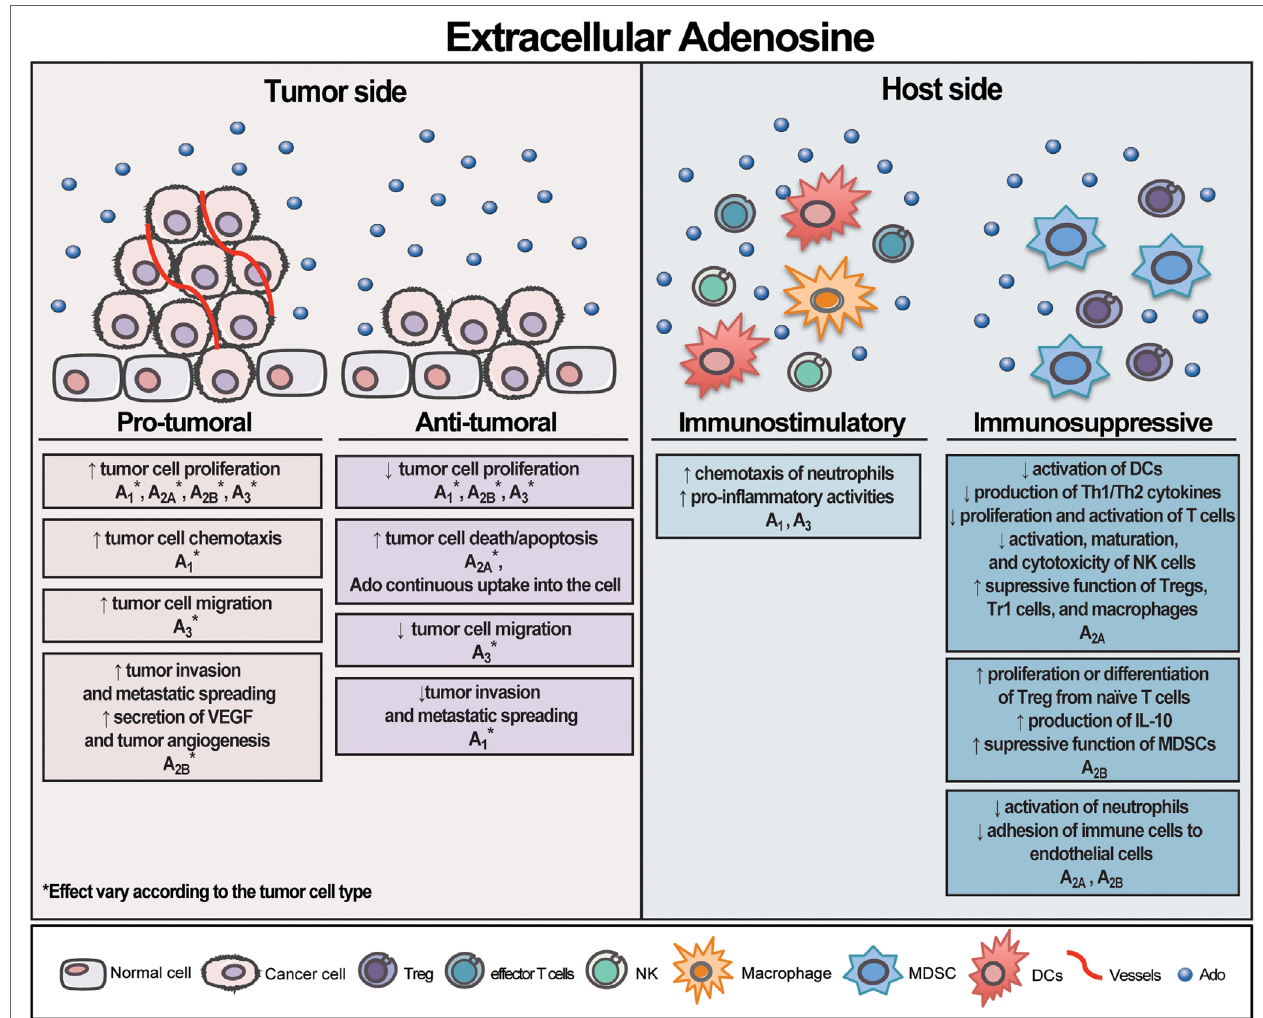
FigURe 2 | Schematic illustration exhibiting extracellular adenosine (eAdo) opposing effects on tumor and host side. Likewise extracellular adenosine triphosphate (eATP), eAdo can exert distinct and contrasting effects on both tumor and host cells depending on the cell type and receptor activated. eAdo can also promote tumor cell death via its continuous uptake into the cell. As depicted by eATP, the sum of eAdo levels, the group of P1 receptor subtypes, and CD39/CD73 expression by tumor and immune cells in the tumor microenvironment will dictate the final effect on tumor growth. Overall, eAdo is a potent immunosuppressive nucleoside, mostly inhibiting immune cell